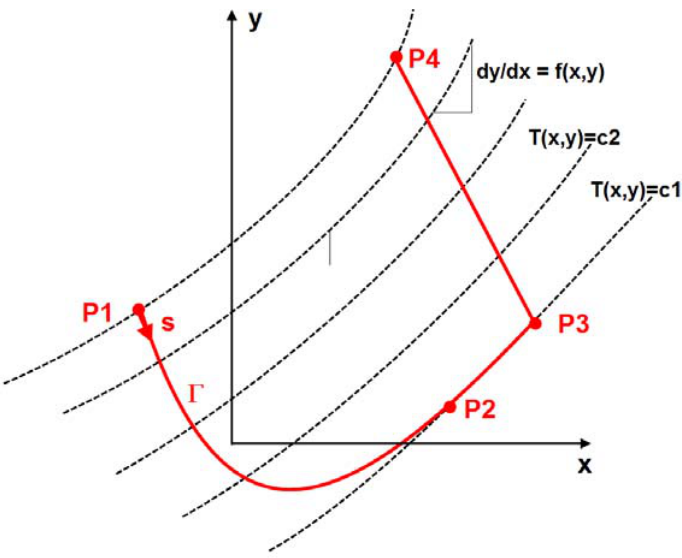
Figure 6. The solution curves T(x,y) of the direction field y´ = f(x,y) are simultaneously the characteristics of the Fourier heat conduction Equation (11). The specification of arbitrary boundary conditions along P2P3 is not permitted since this curve is a characteristic or isoline ( y = const.). According to this, Equation (12) is integrated through the specification of the solution variables T along a curve Γ . However, only the specification on the P1P2 curve is permitted. Since a solution variable is constant on a characteristic, arbitrary specifications along P2P3 are not permitted. Furthermore, arbitrary specifications along P3P4 lead to contradictory definitions with the specifications along P1P2. The curve Γ must not necessarily lie on the exterior boundary, but can also cross the integration